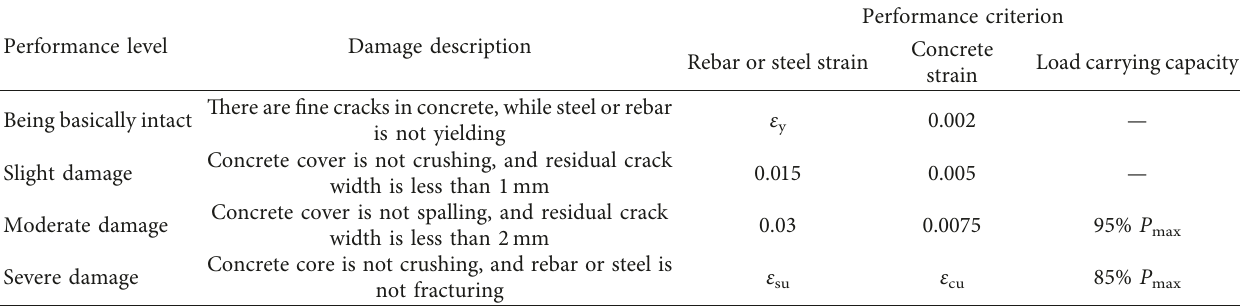
Table 8: Method of defining performance levels for SRC coupling beams.